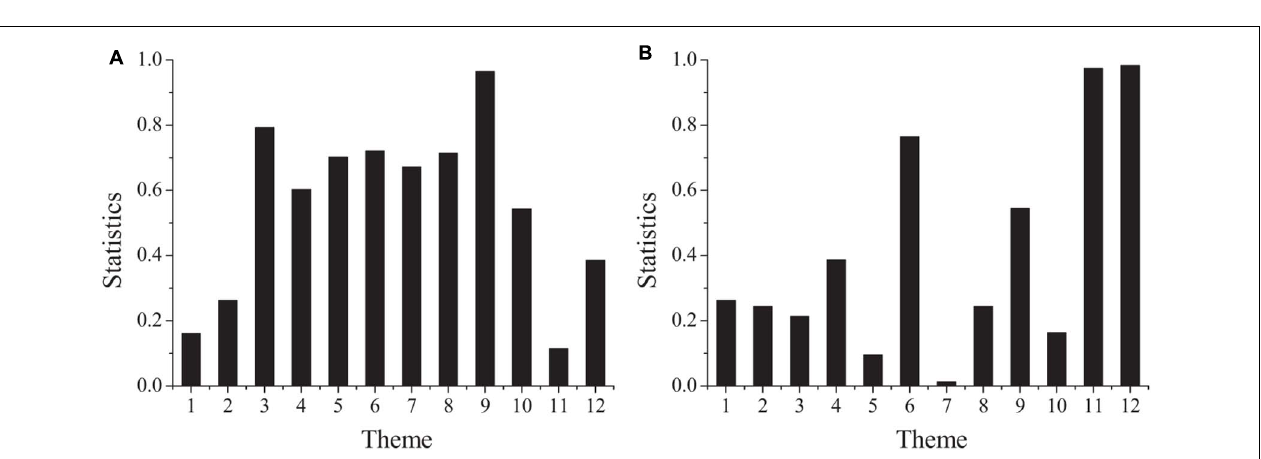
FIGURE 1 | Demographic characteristics of participating researchers ( A: gender; B: educational background; C: position level; D: working years).